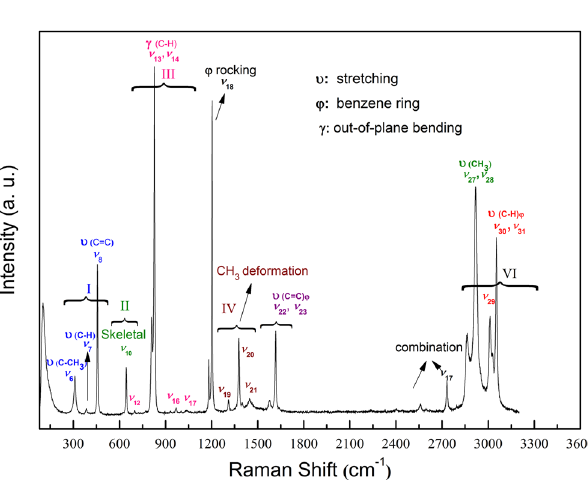
Figure 5. Raman spectrum of p -xylene from 80–3200 cm − 1 under ambient conditions. The vibrational modes and assignments are also shown by